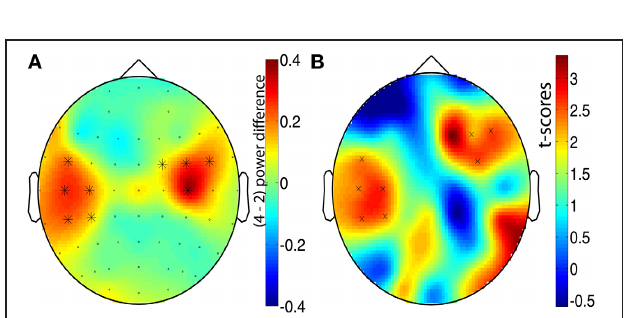
FIGURE 5 | The effect of memory load after sample appearance. Normalized alpha-power (baselined to pre-stimulus) difference between the 4 shapes and 2 shapes condition (4 shapes minus 2 shapes). As the data are normalized, they are unitless. Average between 400ms and 700ms after stimulus onset. The black stars identify the electrodes belonging to clusters that showed significant differences between conditions ( p < 0 . 05, cluster corrected). (A) 12Hz frequency power is modulated by condition. As noted in the text, no memory load effect was found using lower alpha-band (8–10Hz) (B) Electrodes highlighted with x are electrodes where the difference in power between 4 and 2 shapes is significantly higher for upper alpha-band (12Hz) than for lower-alpha-band (8–10Hz). Cluster corrected ( p < 0 . 05).